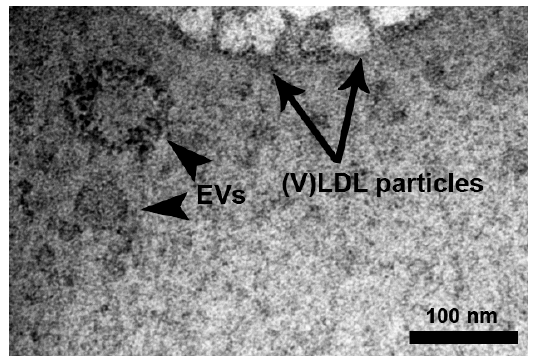
Figure 2. The presence of extracellular vesicles (EVs) in the (V)LDL precipitate. (V)LDL precipitate was processed for electron microscopy as described in the Materials and Methods section. Black arrows indicate bilayer EVs of 60–100 nm in diameter. The blank arrow indicates monolayer lipoprotein particles. Scale bar = 100 nm.